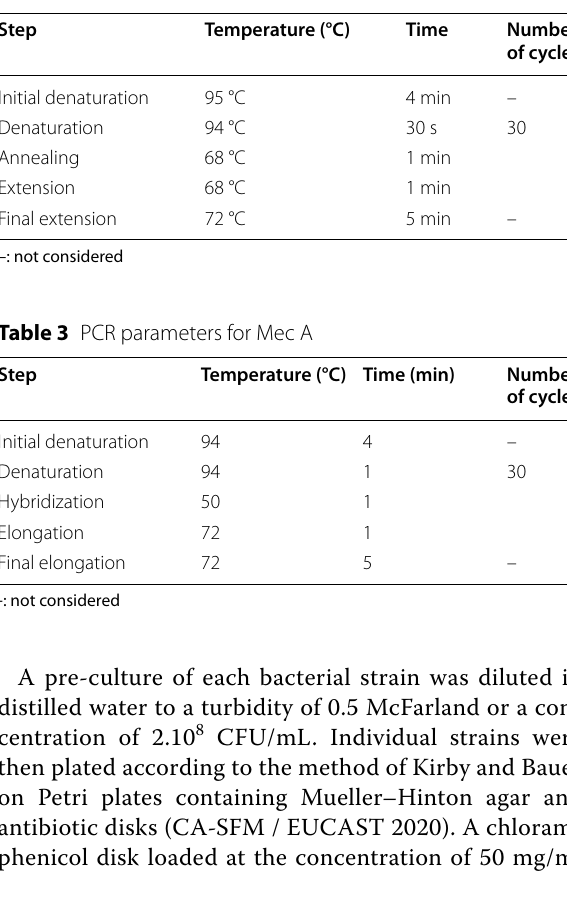
Table 2 PCR conditions for Bla‑TEM, SHV, CTM‑1 and CTM‑15